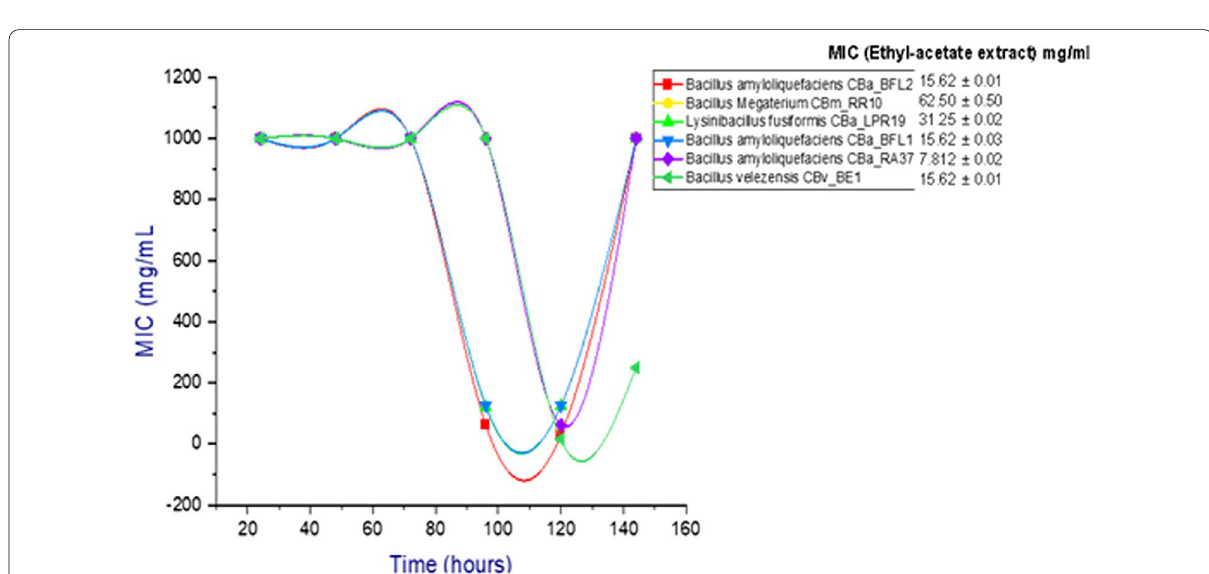
Fig. 2 Variation of MIC of the filtrates and ethyl acetate extracts of endophytic bacterial with respect to culture duration. The experiment was performed in duplicate and repeated twice. Data are expressed as mean values